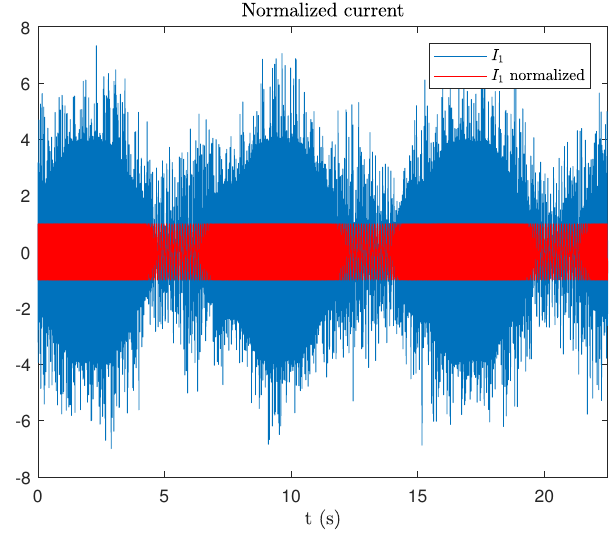
Figure 9. Normalization of the input signal i 1